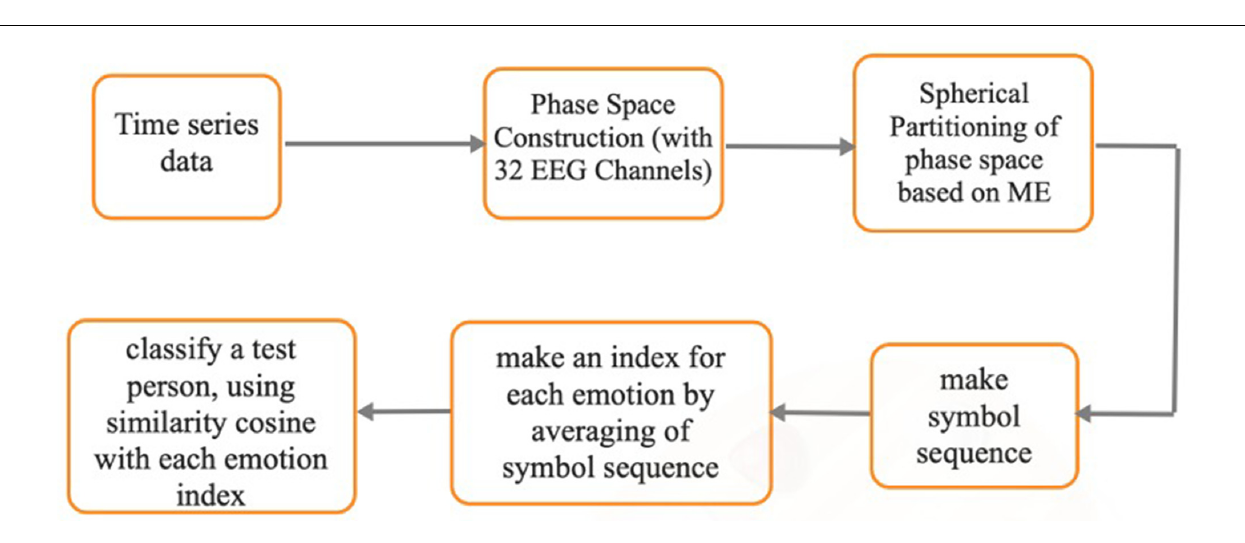
FIGURE 7 | The block diagram of the proposed